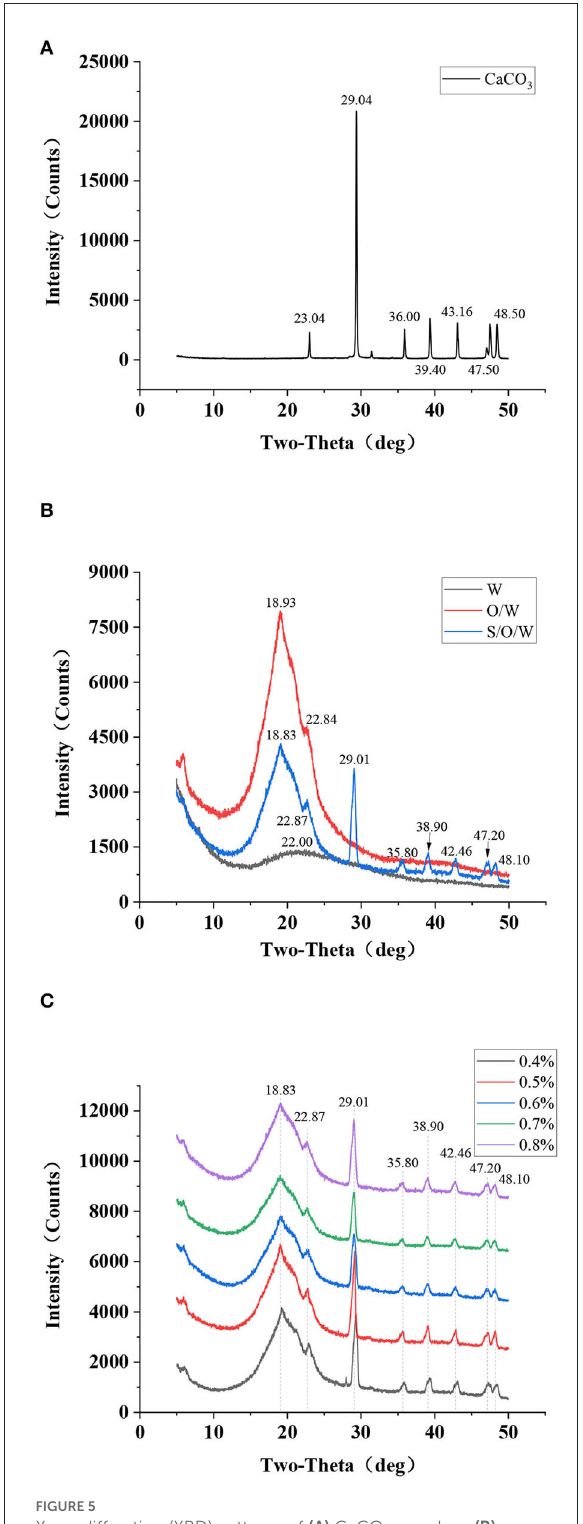
FIGURE5 X-ray diffraction (XRD) patterns of (A) CaCO 3 powders, (B) PGA-XG complexes, O/W emulsion without CaCO 3 , and S/O/W calcium-lipid emulsion, and (C) S/O/W calcium-lipid emulsions formed by different concentrations of PGA-XG